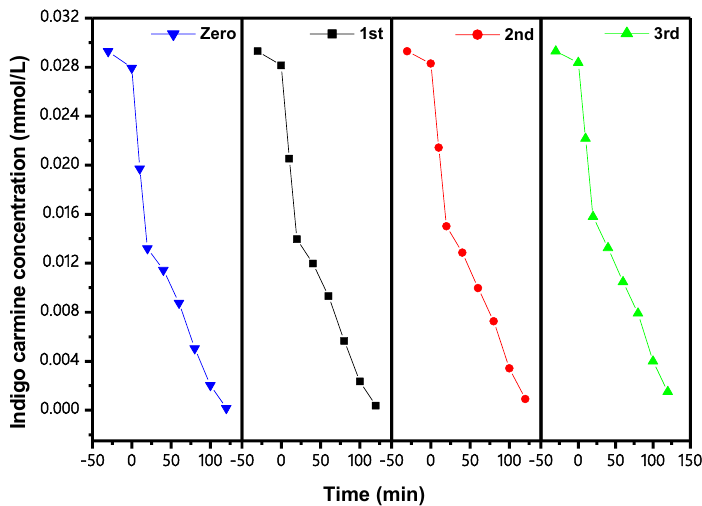
Figure 17. Concentration variation curves of TOC during PCD of IC in DW with IBH as a catalyst or with In 2 YSbO 7 as a catalyst or with BiSnSbO 6 as a catalyst or with N-TiO 2 as a catalyst under VLGI.